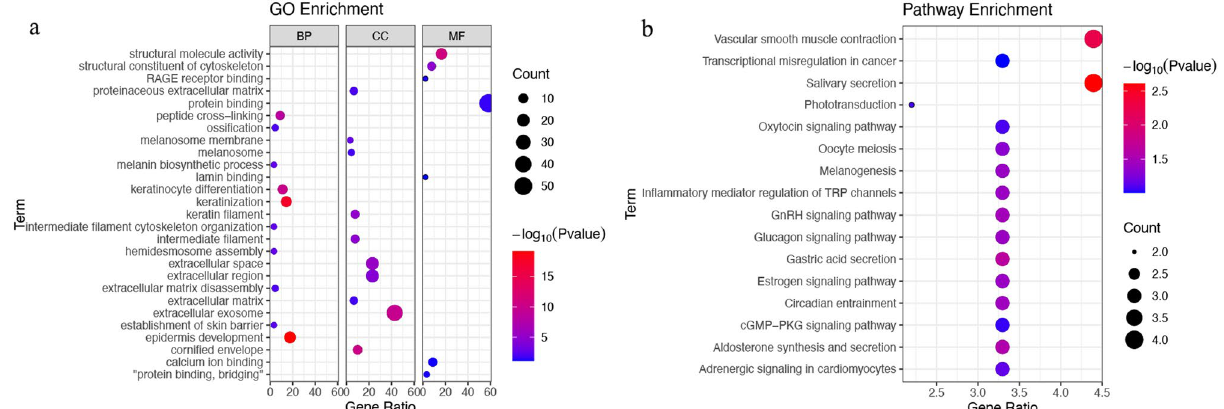
Figure 5. Functional enrichment analysis of DEGs associated with ageing in SKCM. ( a ) The enriched items in gene ontology analysis. ( b ) The enriched items in the Kyoto Encyclopedia of Genes and Genomes analysis. DEG differentially expressed gene, SKCM skin cutaneous